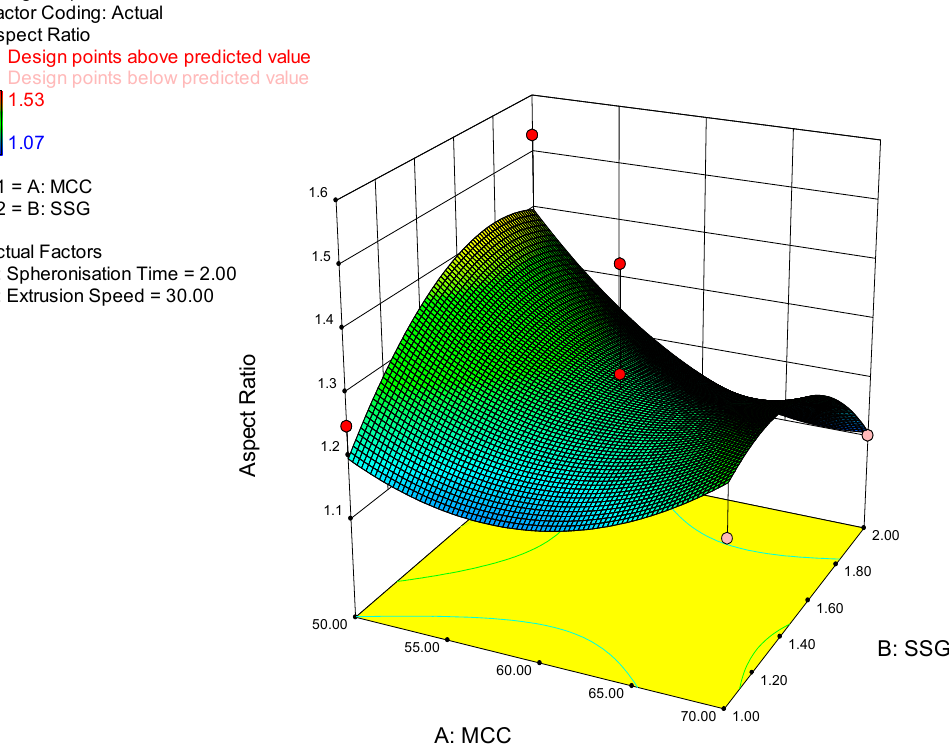
Figure 3. 3D response surface plot depicting the impact of microcrystalline cellulose and sodium starch glycolate concentration on aspect ratio.